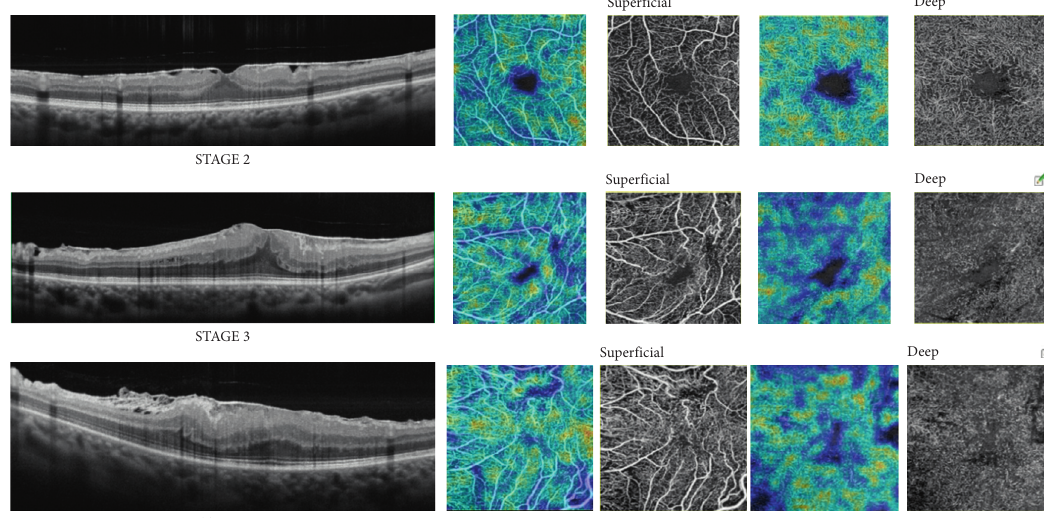
Figure 5: Vessel density and perfusion density correlated to ERM